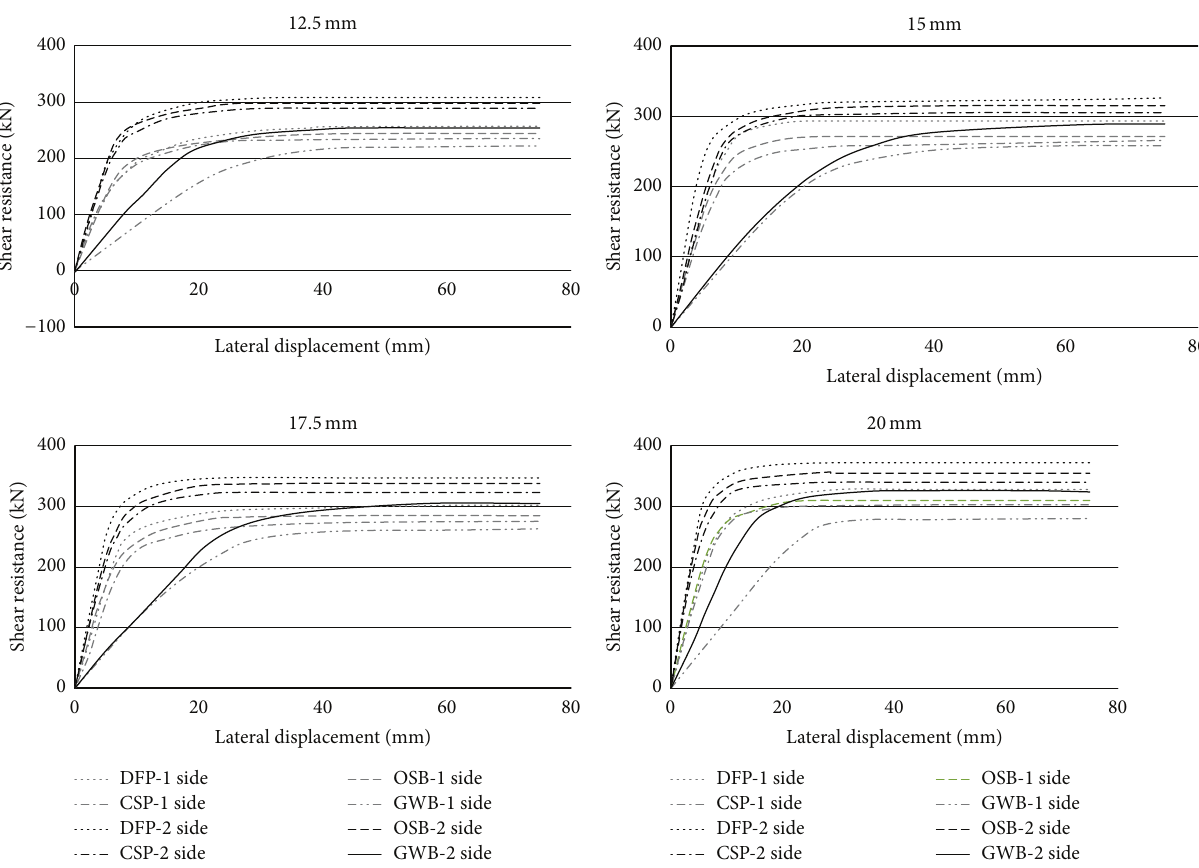
Figure 12: Monotonic curves of sheeting walls with variable of the sheets and